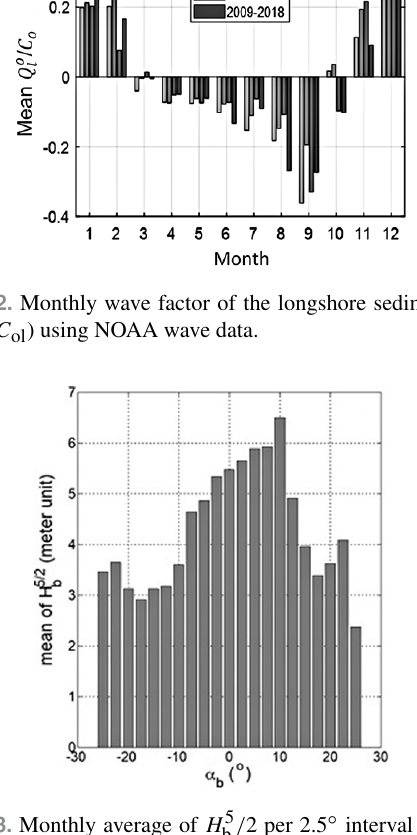
Figure 13. Monthly average of H 5 wave angle α b , obtained from NOAA wave data during winter